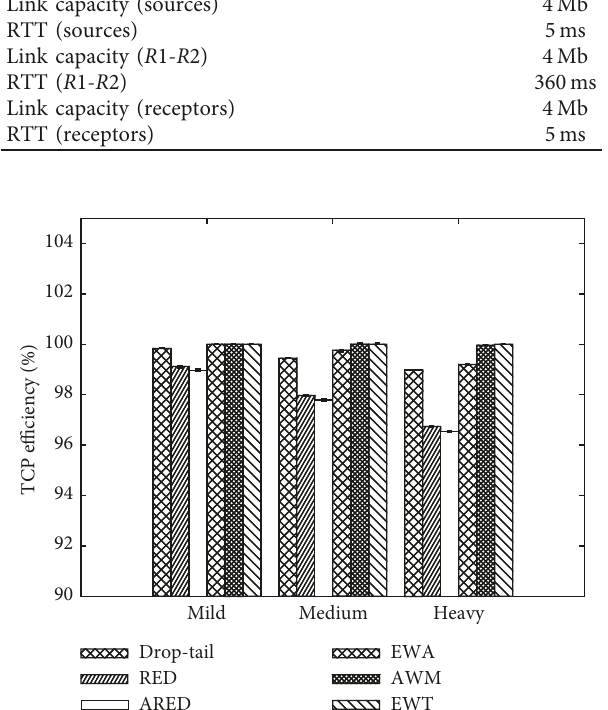
Figure 5: TCP efficiency: Scenario 1.